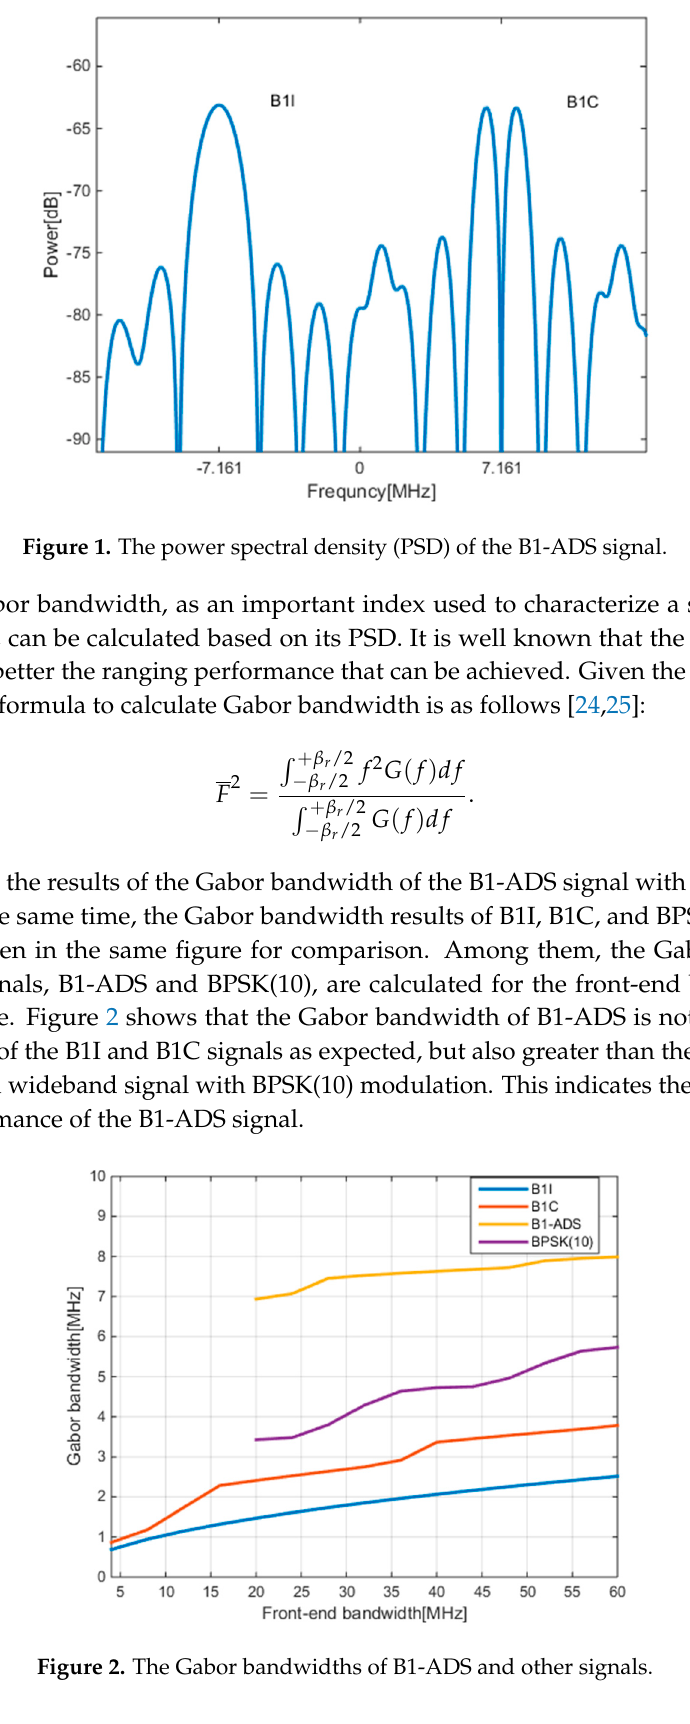
Figure 2. The Gabor bandwidths of B1-ADS and other signals.